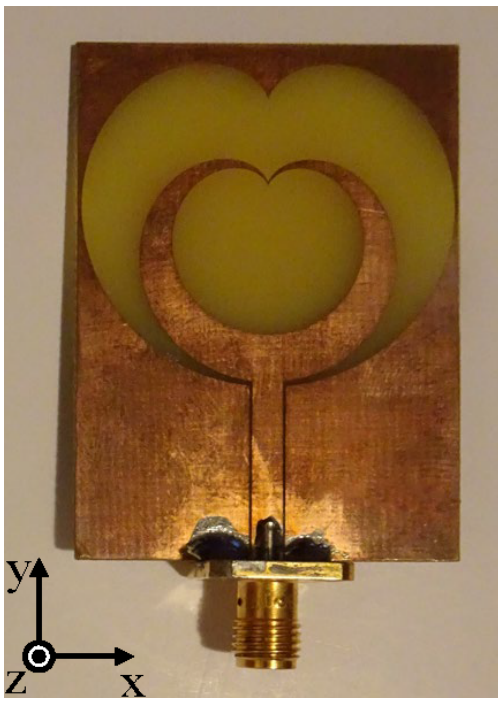
Figure 10. Realized fractal antenna in the form of a cardioid with overall dimensions of 35 mm × 47